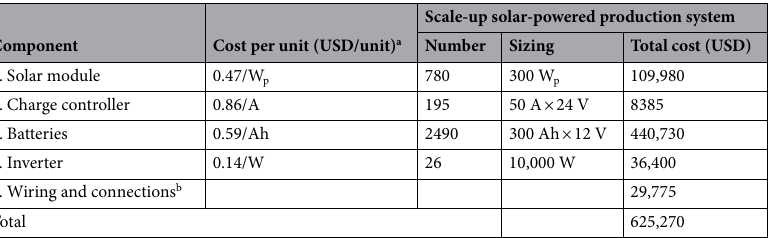
Table 5. Sizing and cost estimation of solar PV system. [ a Cost was calculated based on Egyptian exchange rate, b Wiring and connections 5% of the sum of solar module, charge controller, batteries and inverter 35